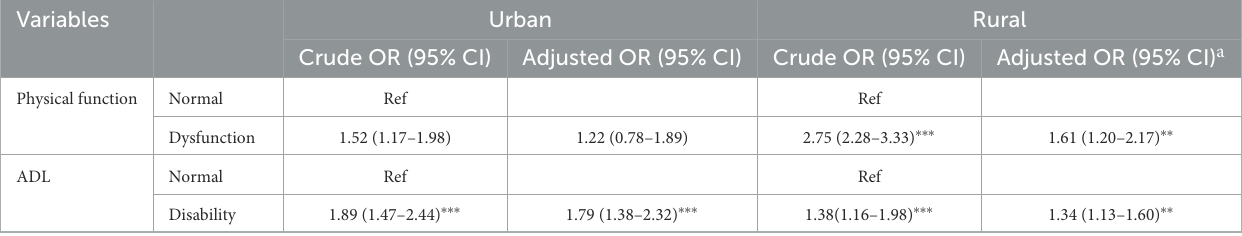
TABLE 5 OR with 95% CI of depressive symptoms according to the physical function and ADL stratified by urban and rural in 2018.